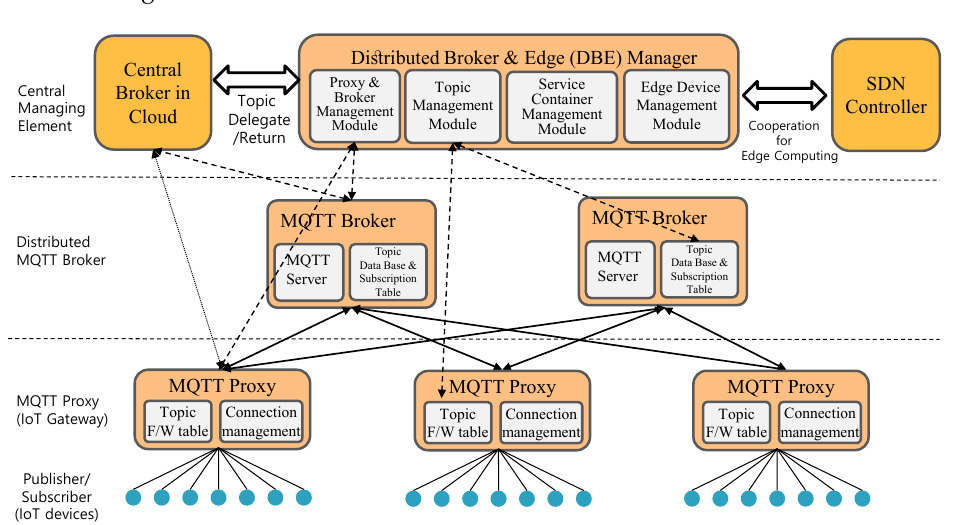
Figure 5. Distributed MQTT architecture based on edge